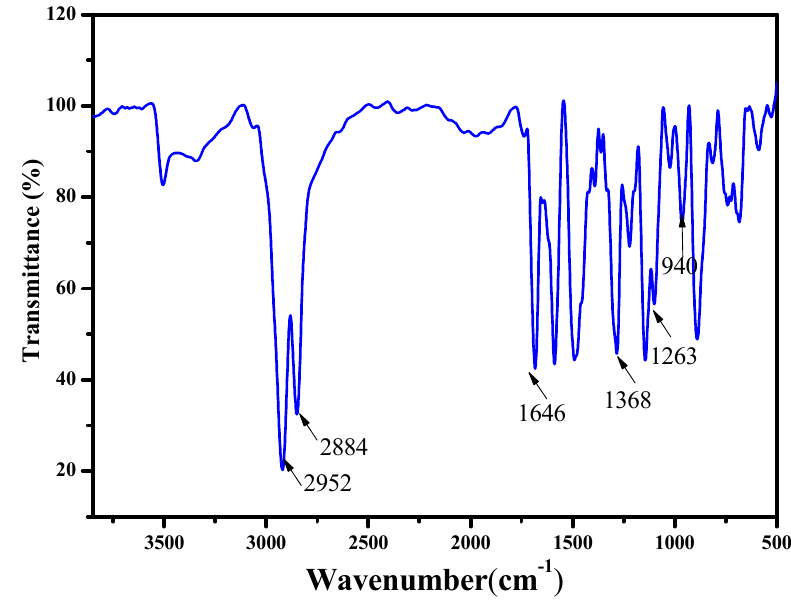
Figure 1. FT ‐ IR spectrum of C ‐ st. Figure 1. FT-IR spectrum of